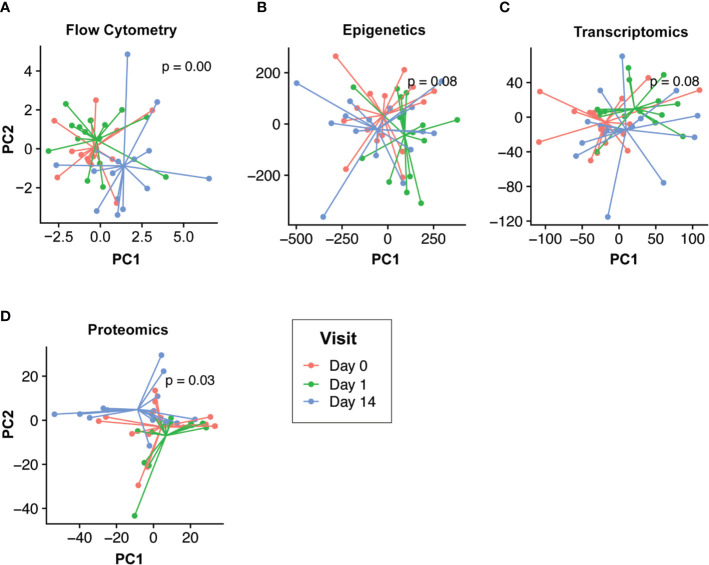
Temporal response profiles following HBV vaccination differs across omics compartments. Low dimensional projection of the flow cytometry (A), epigenomic (B), transcriptomic (C), and proteomic (D) data using multilevel principal component analysis to visualize global changes across time. In each panel, different post-vaccination time points for each individual are shown in red (Day 0), green (Day 1), and blue (Day 14). We observed differing global temporal patterns of change following vaccination across the various omics compartments. Epigenomic and transcriptomic profiles changed rapidly post-vaccination (Day 1; green vs. blue/red) before returning to baseline by Day 14. Conversely, flow cytometry and proteomic profiles were most distinct by Day 14 (blue vs. red/green).